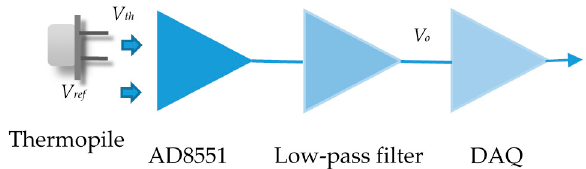
Figure 5. Amplification circuit for the thermopile.